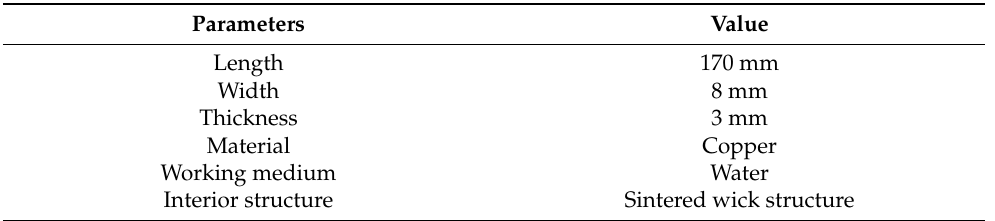
Table 1. Parameters of the HPs used in this